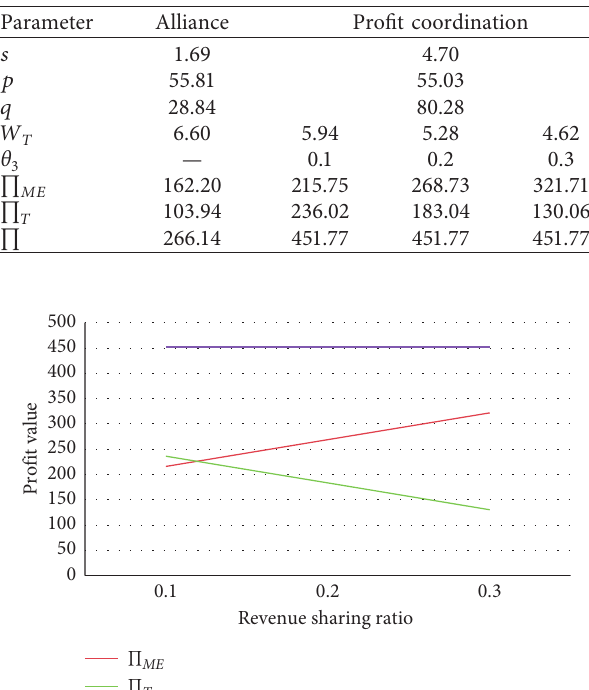
Table 8: Coordination results of revenue sharing in semi- centralized model 2.